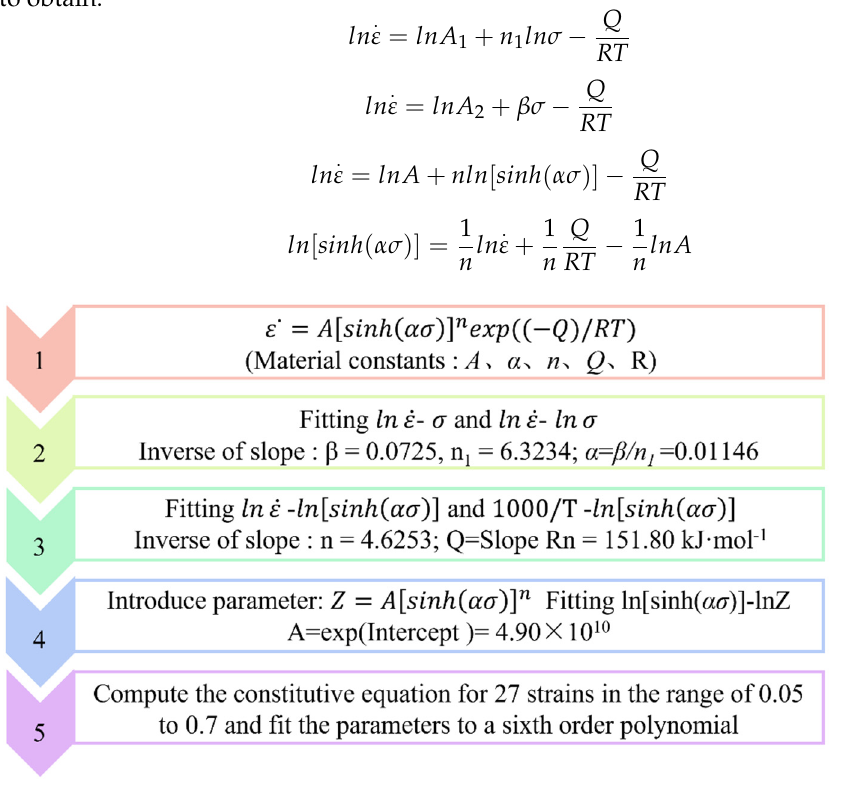
Figure 3. Flow chart for solving AR model parameters.